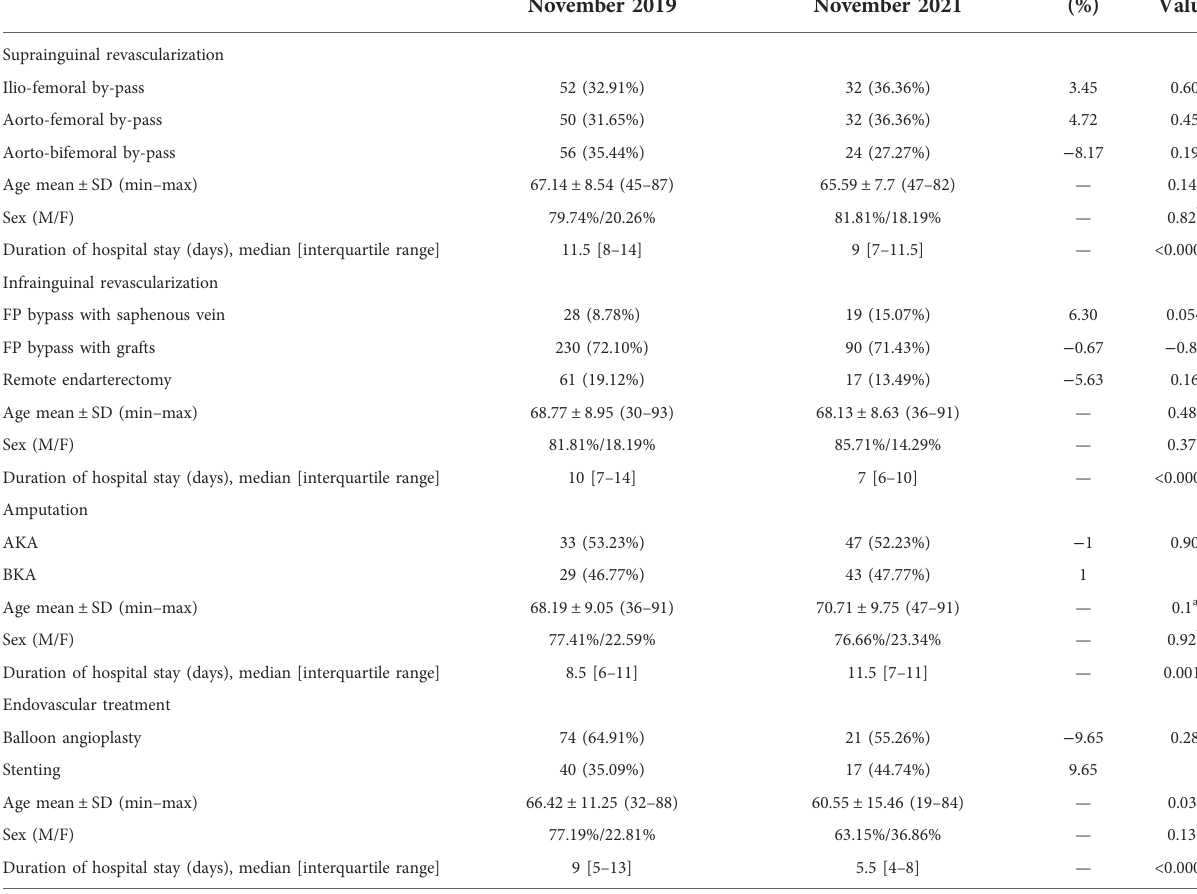
TABLE 4 Types of surgeries and their characteristics for both periods — part